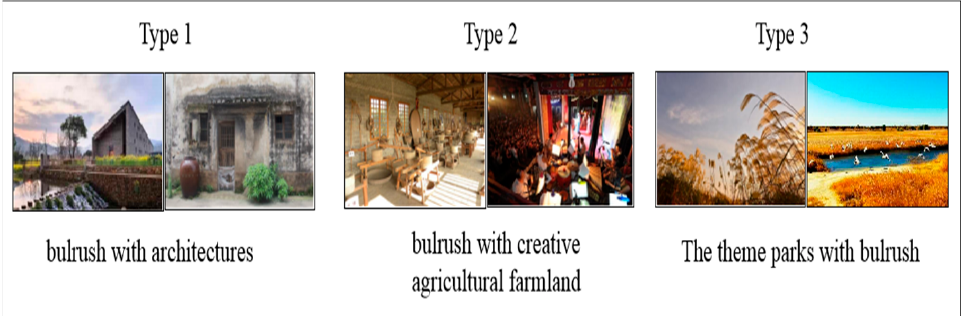
Figure 4. Design of bulrush landscape in Pu’an village.